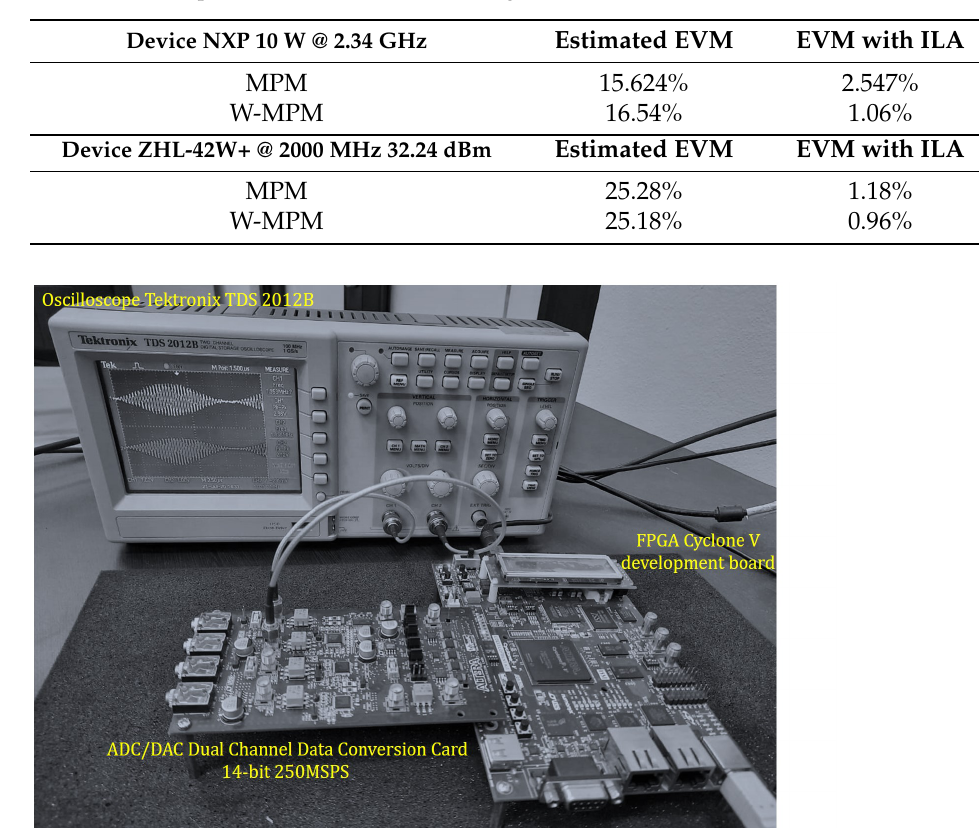
Table 6. EVM improvement based on the ILA algorithm for the MPM and W-MPM models.